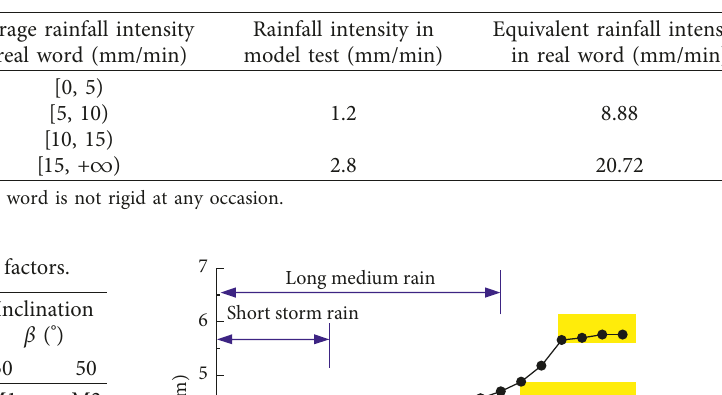
Table 4: Rainfall intensity classification in this test.